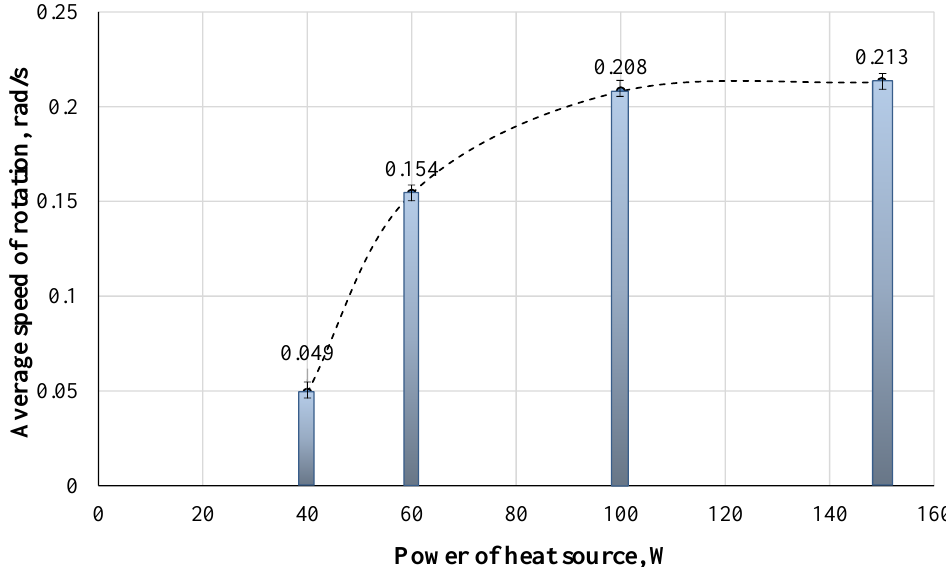
Figure 10. The relationship between the angular velocity of the broad leaved lime ( Tilia platyphyllos Scop ) leaf (leaf rotation) and the power of light source.